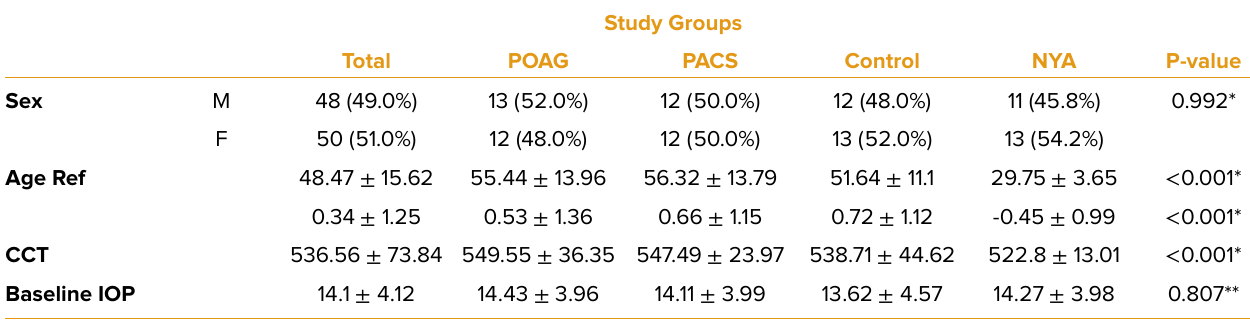
Table 1. The baseline demographic and clinical characteristics of the study participants.